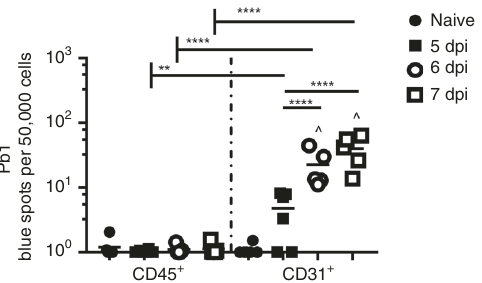
Fig. 6 Lung endothelial cell cross-presentation of PbA luc antigen to Pb1- speci fi c CD8 + T cells during PbA luc infection. Lung microvessels were isolated from naive ( n = 6) and PbA luc -infected C57BL/6 5 ( n = 6), 6 ( n = 5) and 7 dpi ( n = 5), and sorted into two populations: CD45 + CD31 − leukocytes and CD45 - CD31 + endothelial cells. Each sorted population was tested for Pb1 cross-presentation by incubating with LR-BSL8.4a cells and staining with X-gal. The spot count was normalized per 50,000 cells and is represented on a log scale. The data represent the mean; ** p < 0.01, **** p < 0.0001, ^ statistically signi fi cant compared to naive mice ( p < 0.05)